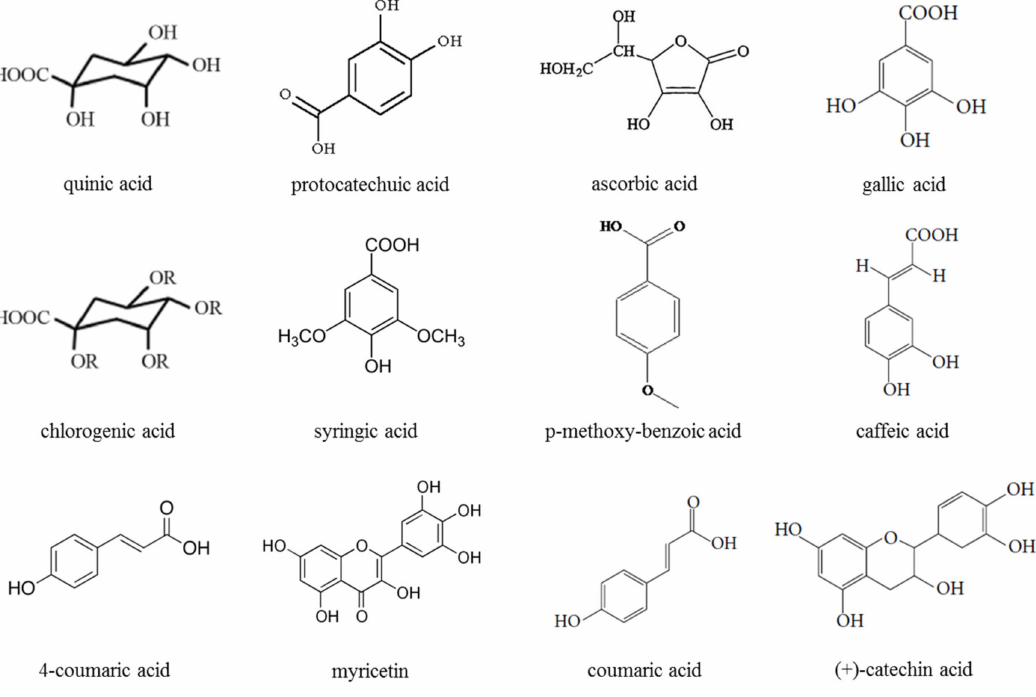
Figure 2. Chemical structure of phenolics and flavonoids isolated from M. charantia